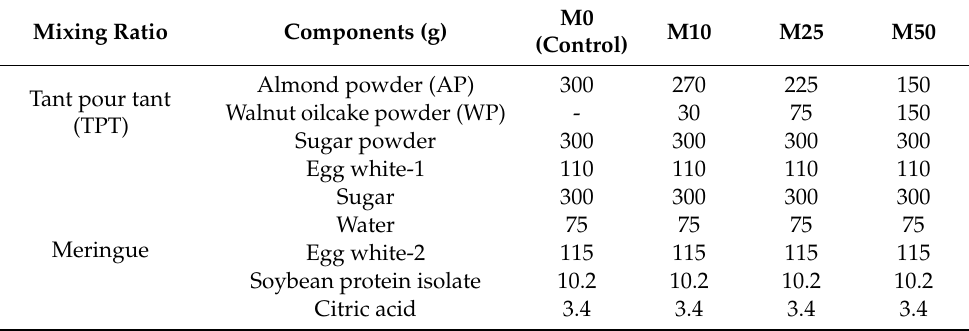
Table 8. Formulation used for the preparation of modified